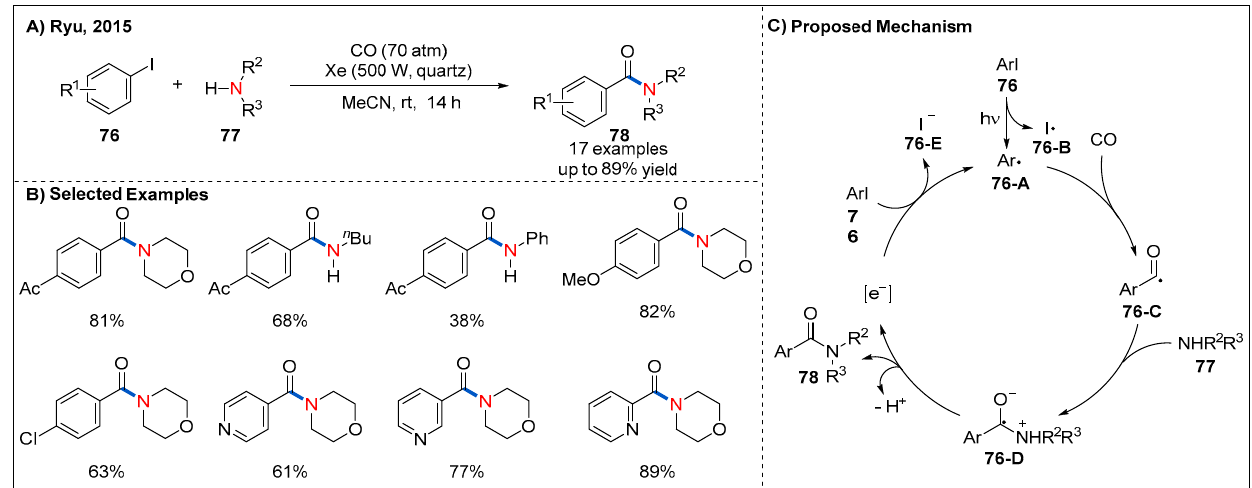
Figure 25. Photoinduced catalyst-free radical aminocarbonylation of aryl and heteroaryl iodides.